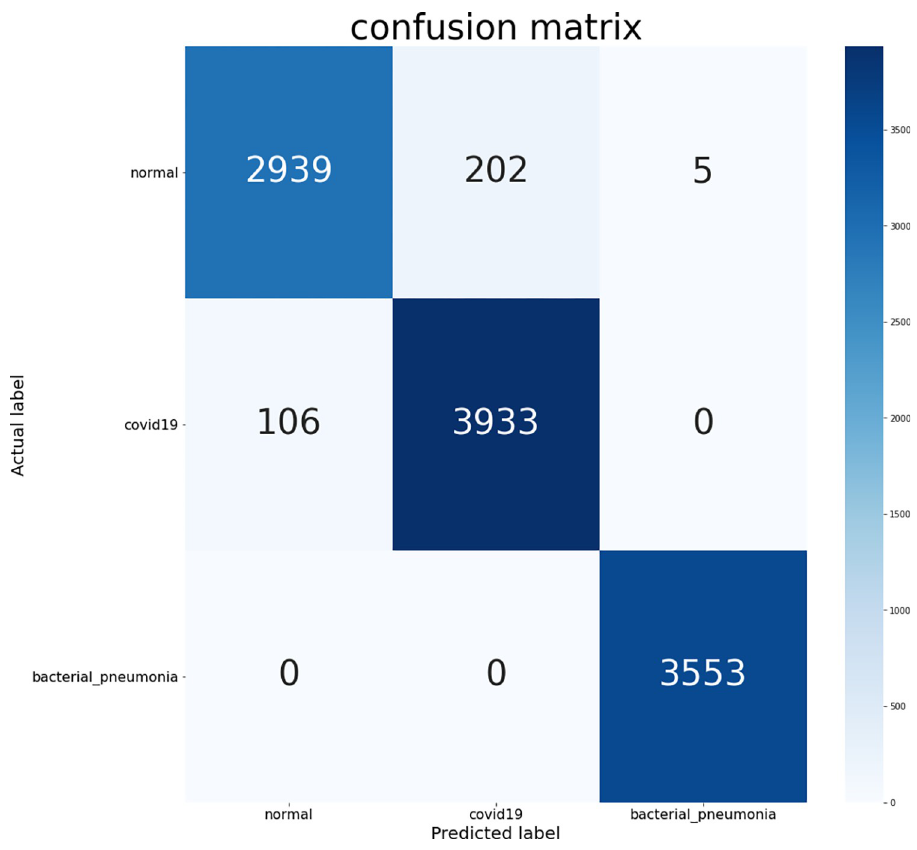
Fig 8. The confusion matrix of the proposed model.